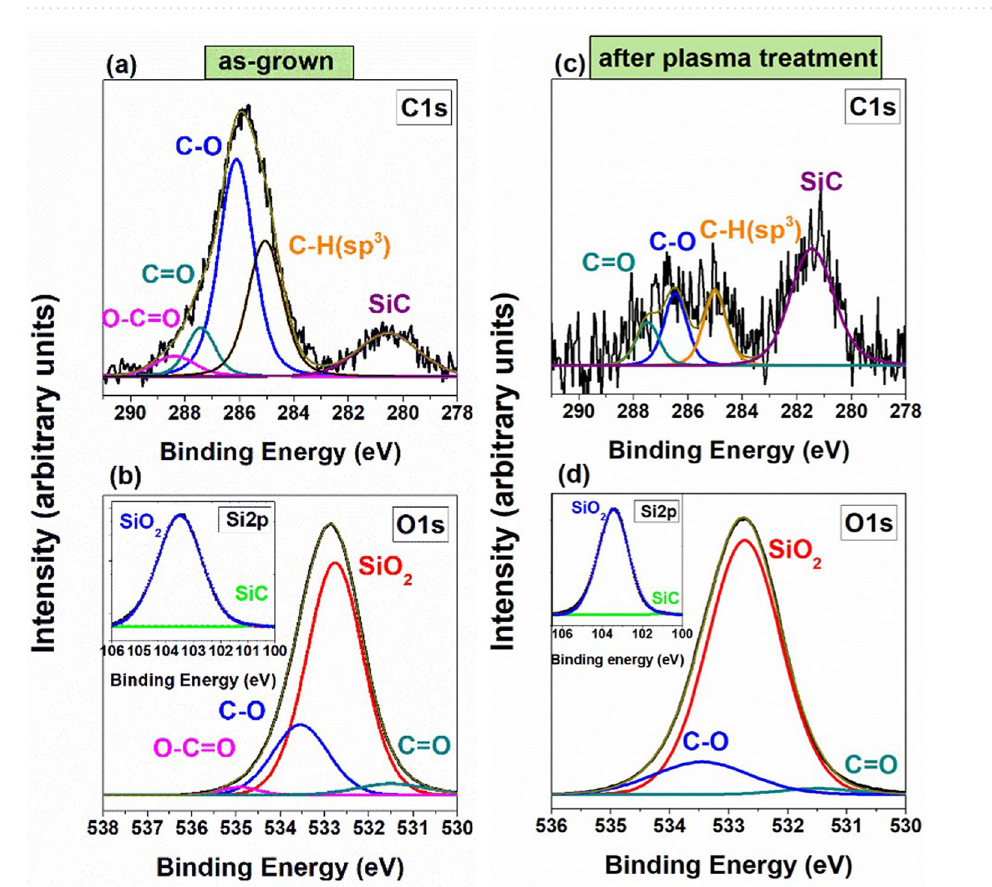
Figure 2. The XPS spectra of HDP-SiO 2 oxide ( a ) C 1s spectra, ( b ) O1s spectra, ( b inset ) – Si 2p spectra—for as-grown HDP oxide; ( c ) C 1s spectra ( d ) O 1s spectra ( b inset )—for plasma treated HDP- SiO 2